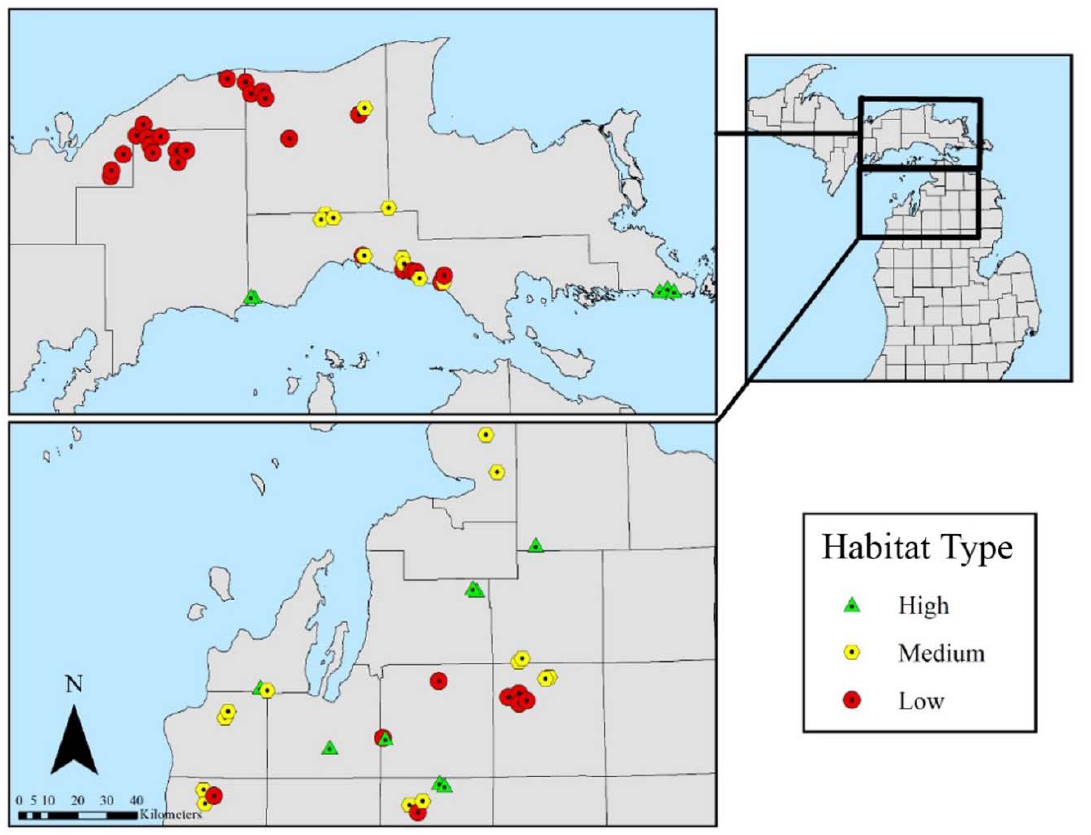
Figure 2. Distribution of 69 sites by habitat type indicating high, medium, and low site quality within the northern hardwood forest cover type [14]: Types are unique to each peninsula. High (i.e., high quality and the highest nutrient and moisture regime) types are AFOCa and AFOA, medium types are AFO and AFPo, and low types are PArVVb and ATFD in the NLP and EUP,